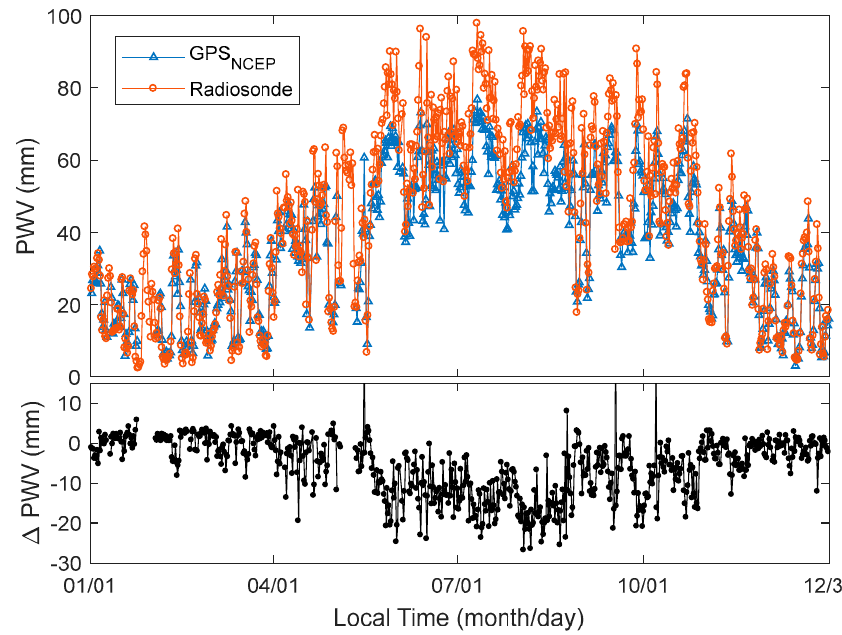
Figure 6. PWV computed by the radiosonde balloon sensors and GPS with NCEP CFSv2 re-analysis dataset (top panel) and PWV differences between radiosonde and GPS and NCEP at Taiz GPS station in 2016 (twice a day, at 07:15 and 19:15).